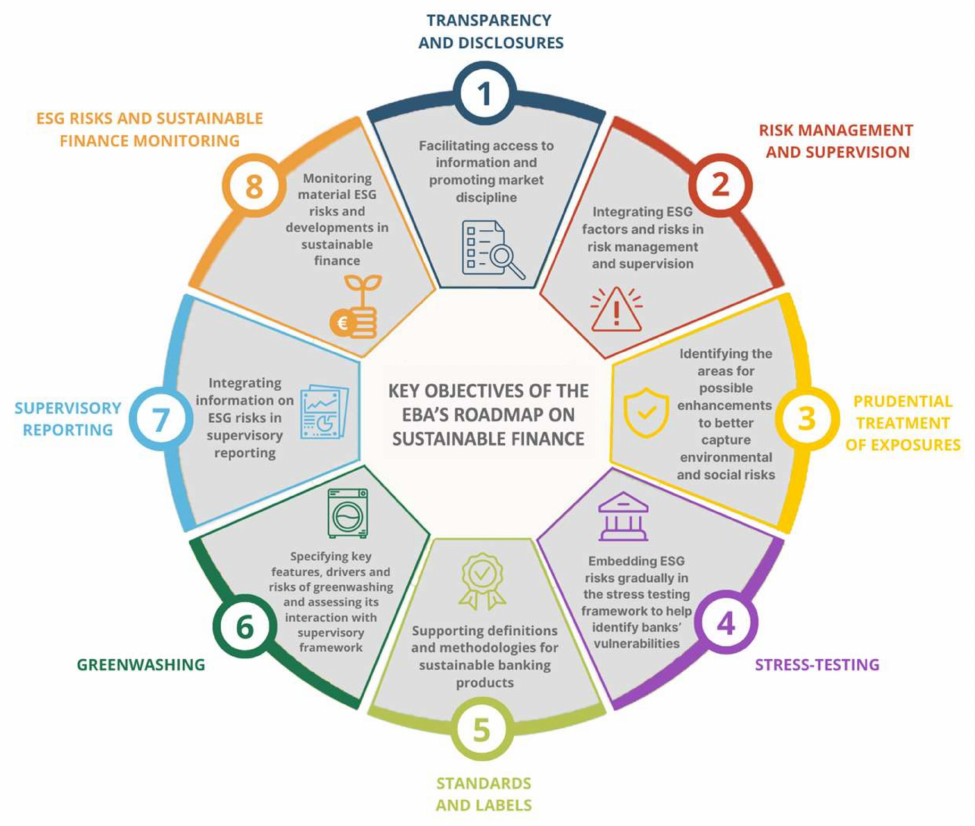
Figure 2. Key objectives of the EBA’s Roadmap on Sustainable Finance. Source: https://www.eba.eu ropa.eu/eba-publishes-its-roadmap-sustainable-finance (accessed on 10 December